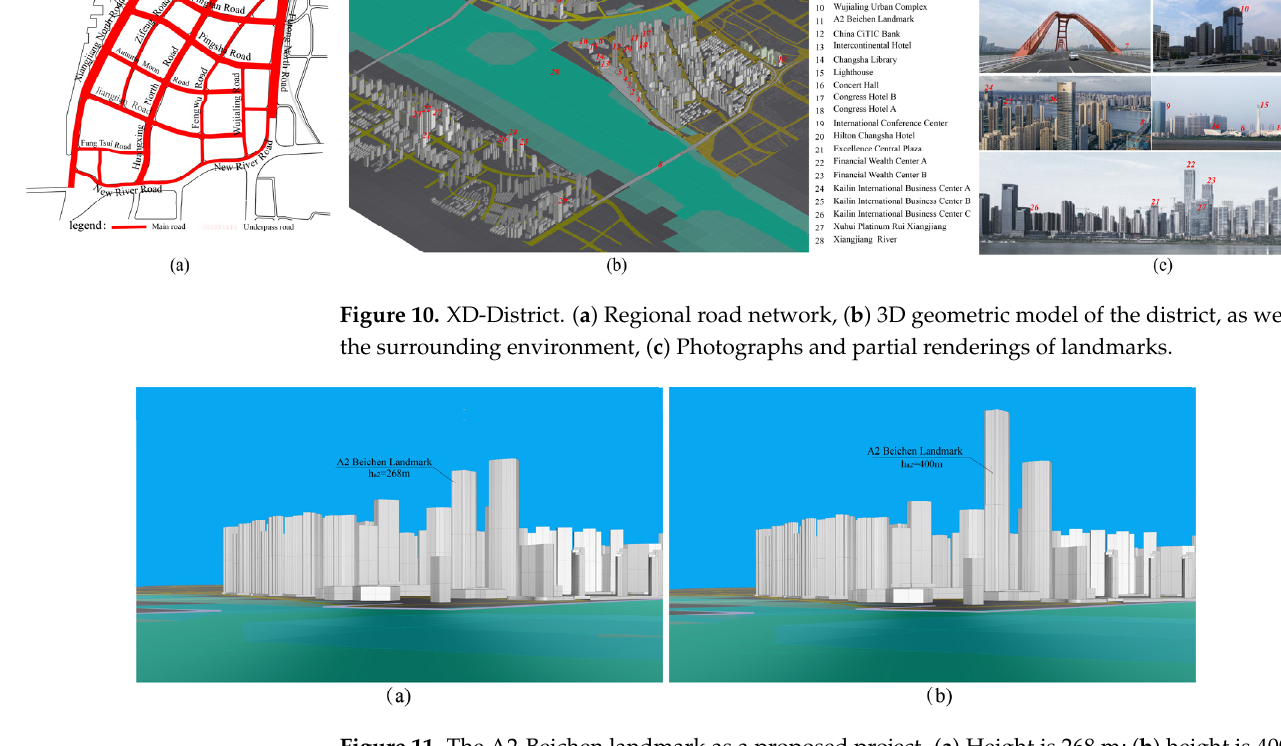
Figure 11. The A2-Beichen landmark as a proposed project. ( a ) Height is 268 m; ( b ) height is 400 m.